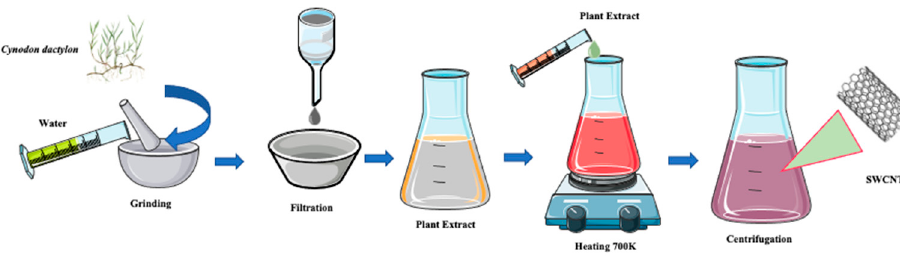
Figure 3. Green synthesis of SWCNTs from garden grass ( Cynodon dactylon ) by the CVD process. The CNTs produced from walnut extract through the CVD process (at 575 °C) are of high quality and good yield when compared to other plant extracts that have been used. was observed; carbon nano belts (CNBs) were detected. Their presence was confirmed using scanning electron microscopy, IR and Raman characterization [104].